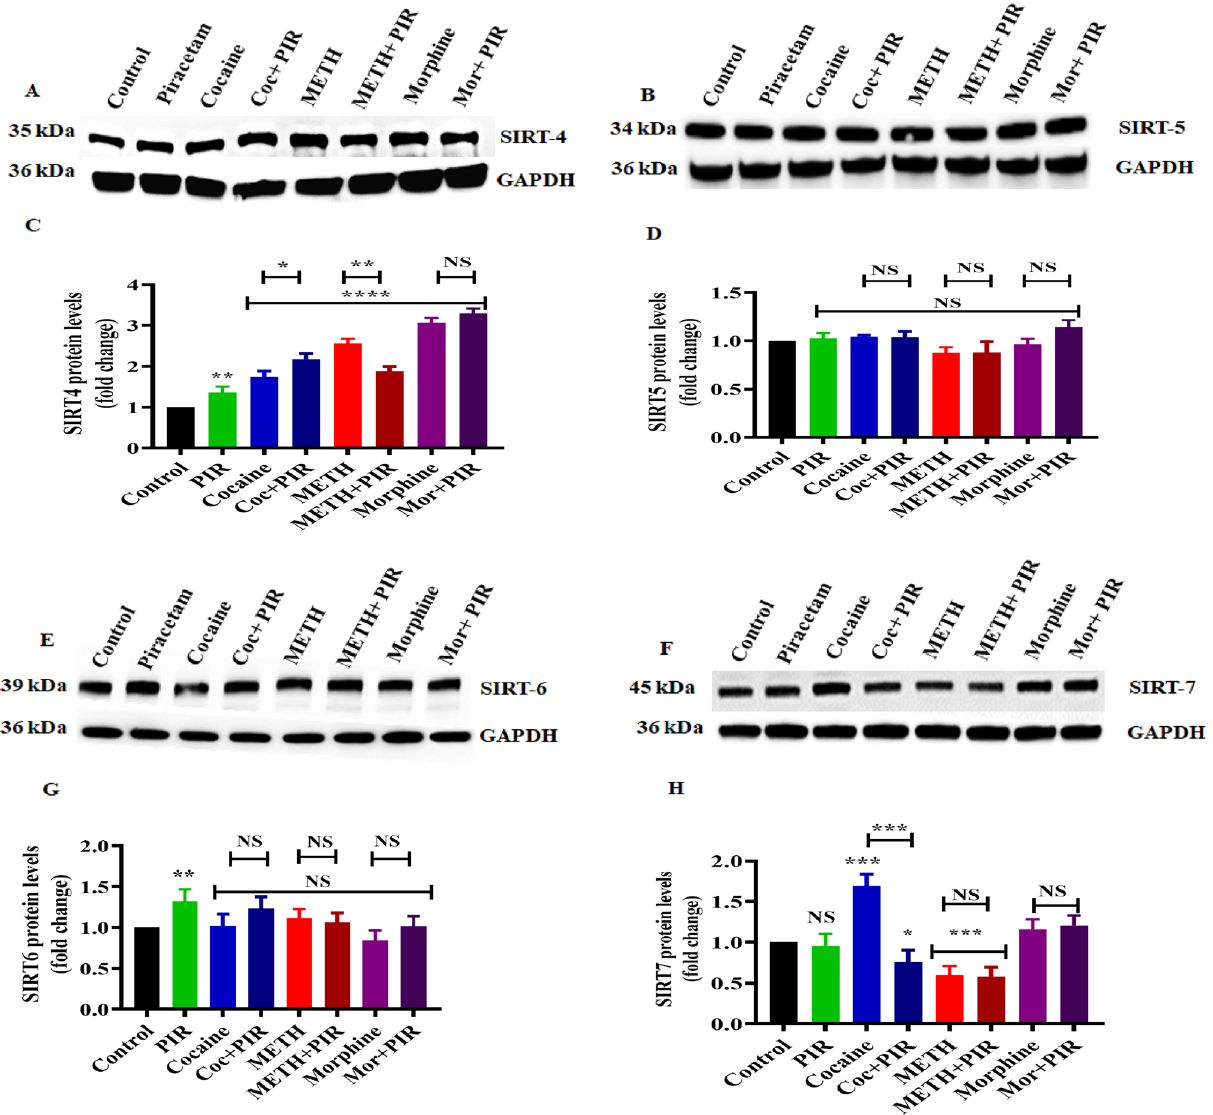
Figure 6. The protective effects of piracetam against psychostimulants and opioids on class II-IV SIRT protein expression in human astrocytes. Cells were exposed to cocaine (1 µM), METH (10 µM) and morphine (5 µM) alone or in combination with piracetam (10 µM) for 24 h. Controls were maintained in drug-free medium (without drug exposure). Representative blots showing the expression of ( A ) SIRT-4, ( B ) SIRT-5, ( E ) SIRT- 6, and ( F ) SIRT-7. ( C ), ( D ), ( G ) and ( H ) Densitometric analyses of each protein level to its corresponding GAPDH loading control (fold-change from control). Data are expressed as the means ± SD of three independent experiments. ***P < 0.001, **P < 0.01, *P < 0.05, NS—Nonsignificant. Coexposure of psychostimulant or opioid with piracetam compared to psychostimulant or opioid alone. The supplementary information includes all full- length